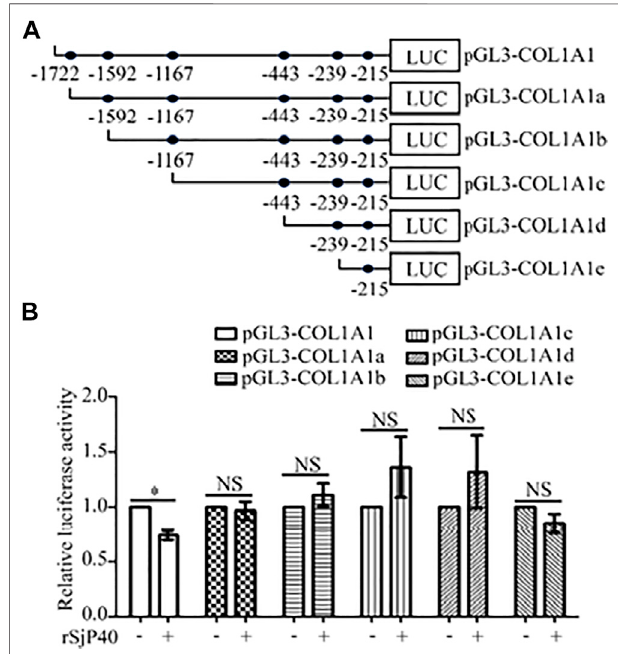
FIGURE 2 | rSjP40 down-regulated the promoter activity of COL1A1 at the core region of - 1,722/-1,592. (A) Diagram of the construction of COL1A1 promoter truncated fragments. (B) The activity of COL1A1 promoter in LX-2 cells transfected with pGL3-COL1A1 was obviously inhibited by rSjP40. * p < 0.05, compared to pGL3-COL1A1+ rSjP40-group. However, rSjP40 could not affect the luciferase activity in LX-2 cells transfected with the empty pGL3-basic vector, pGL3-COL1A1, pGL3-COL1A1a, pGL3-COL1A1b, pGL3-COL1A1c,pGL3-COL1A1dorpGL3-COL1A1ereporterplasimid.NSP > 0.05, compared to each control group with no rSjP40 stimulation. NS, no signi fi